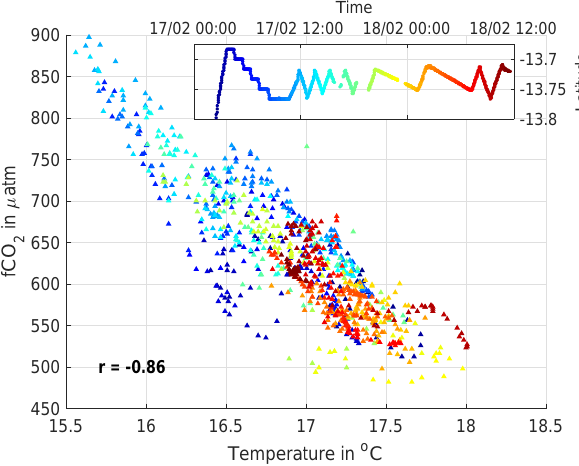
Figure 3. Correlation of surface temperature and f CO 2 during the main experiment. The f CO 2 values are corrected for a 4min time lag. The correlation value r is given in the bottom left corner. Data points are color-coded by their time of measurement. The top right box shows an orientation as to when the data were measured during the experiment. The color-coding carries the same information as the time